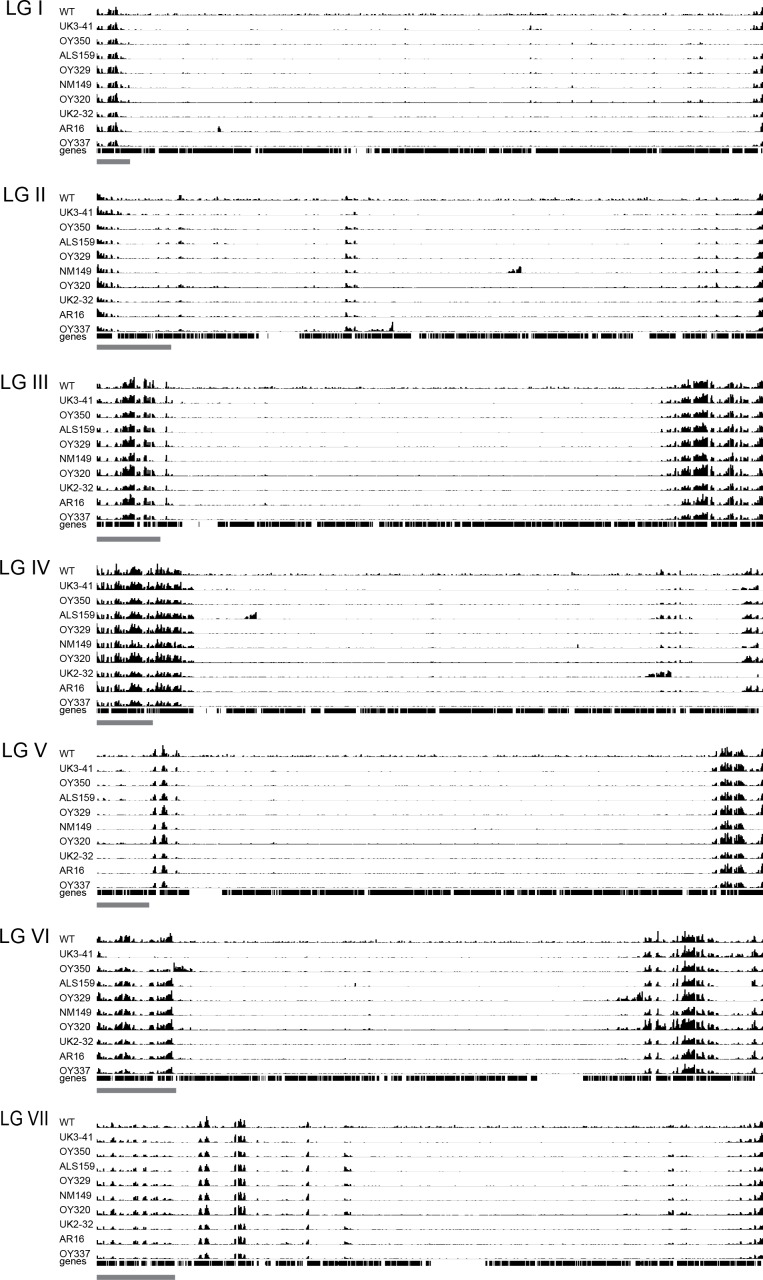
Whole genome view of H3K27me2/3 ChIP-seq in WT and chromosomal translocation strains.H3K27me2/3 ChIP-seq for all seven N. crassa chromosomes is displayed for WT and nine chromosomal translocation strains mapped onto the WT genome. Genes are indicated below the ChIP-seq track as vertical black bars. Grey scale bar represents 500 kb.